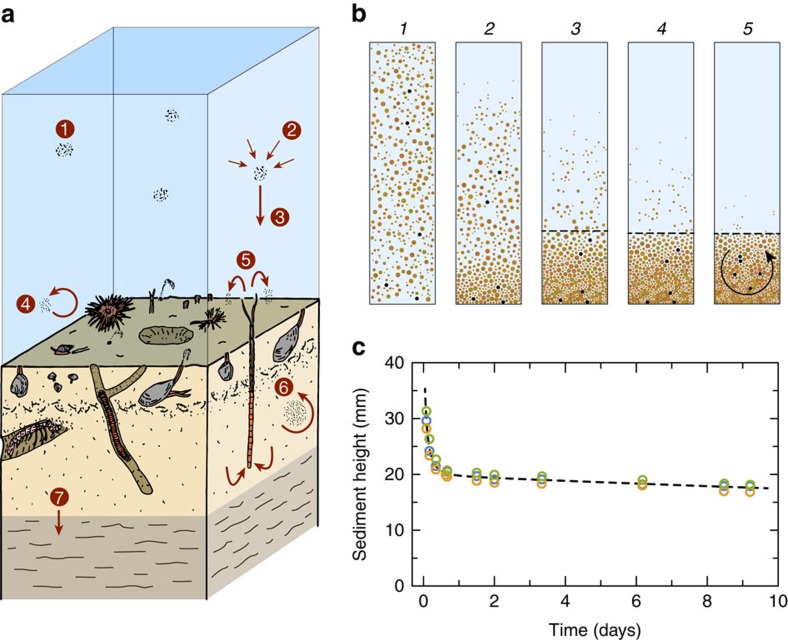
Magnetization acquisition of sediment in nature and in the laboratory.(a) Schematic representation of natural processes affecting sedimentary magnetizations (modified from ref. 15). 1: Marine snow, 2: flocculation, 3: settling, 4: sediment resuspension, 5: non-local mixing, for example, by polychaete worms, 6: local (diffusive) sediment mixing leading to particle reorientation and 7: burial in the consolidating layer. (b) Schematic representation of sediment redeposition in five different time frames. A homogeneous sediment suspension settles in a magnetic field forming a clear sediment–water interface (dashed line) after some time. The same five particles are highlighted by black dots in each frame. A DRM is acquired by the alignment of magnetized particles in the ambient field during deposition (frames 1–4). This magnetization is stabilized by inter-particle forces developing at contact points (frames 3–4). Sediment mixing (arrow in frame 5) is responsible for particle realignment after deposition and generates a PDRM. Only local (diffusive) sediment mixing is produced in our experiments. (c) Height of the sediment–water interface (dots), for three redeposition experiments. The dashed line is a guide for the eye. A nearly stable interface is obtained within the first day.